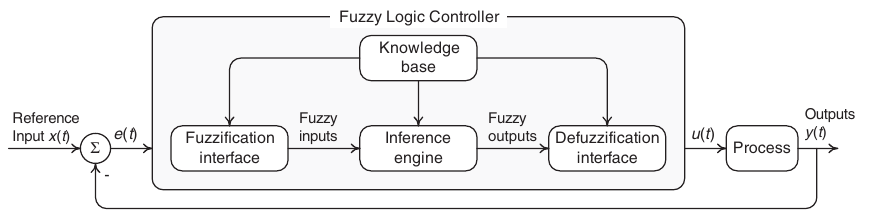
Fig. 4. Schematic of the FLC with basic structure.